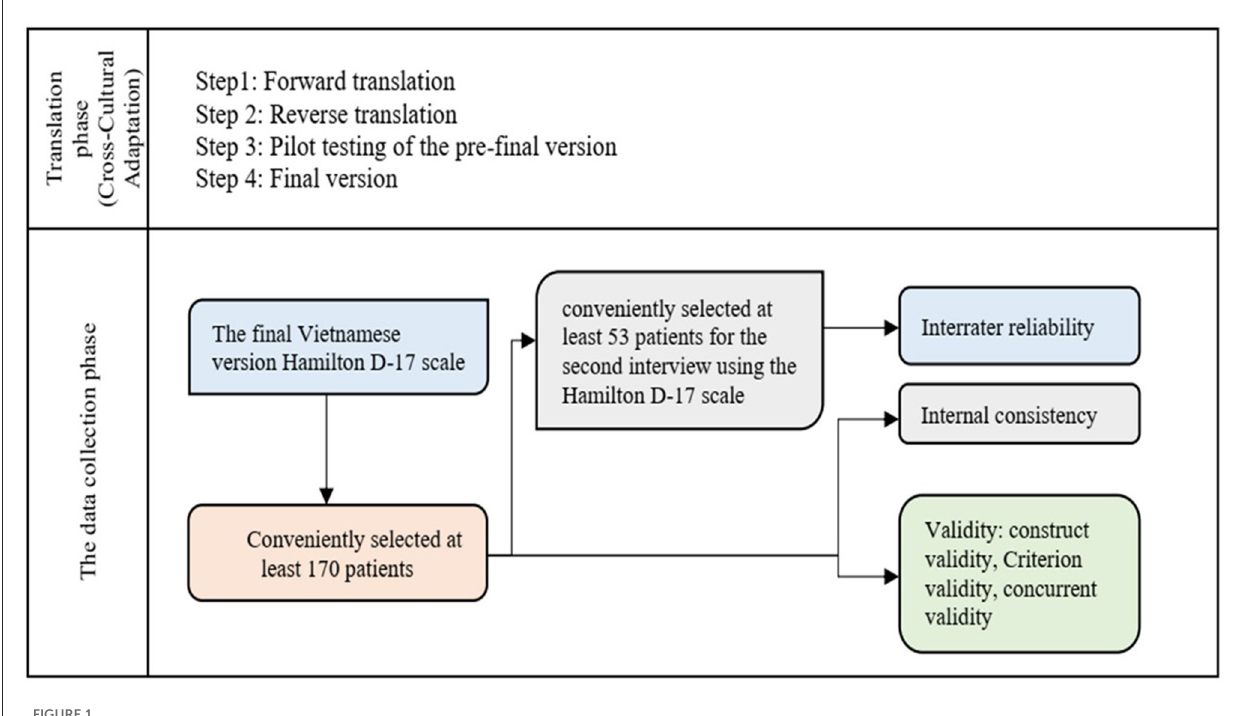
FIGURE1 Translation of the Hamilton D-17 and study